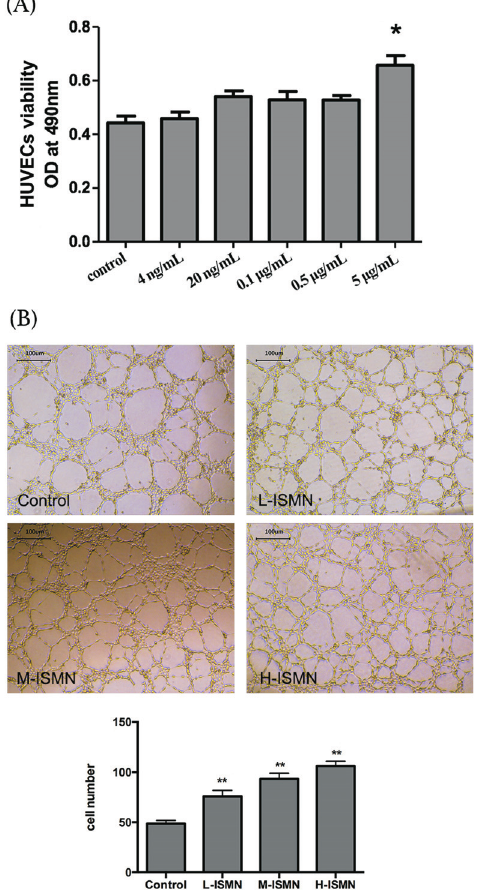
Figure 5 - Effects of ISMN on HUVECs viability and proliferation. (A) HUVECs viability determined by MTT. (B) HUVECs proliferation. L-ISMN, 0.05 (cid:3) g/mL; M-ISMN, 0.5 (cid:3) g/mL; H-ISMN, 5 (cid:3) g/mL. DMEM treatment was used as control. Data were expressed as mean (cid:5) SD (n = 3). * p < 0.05.